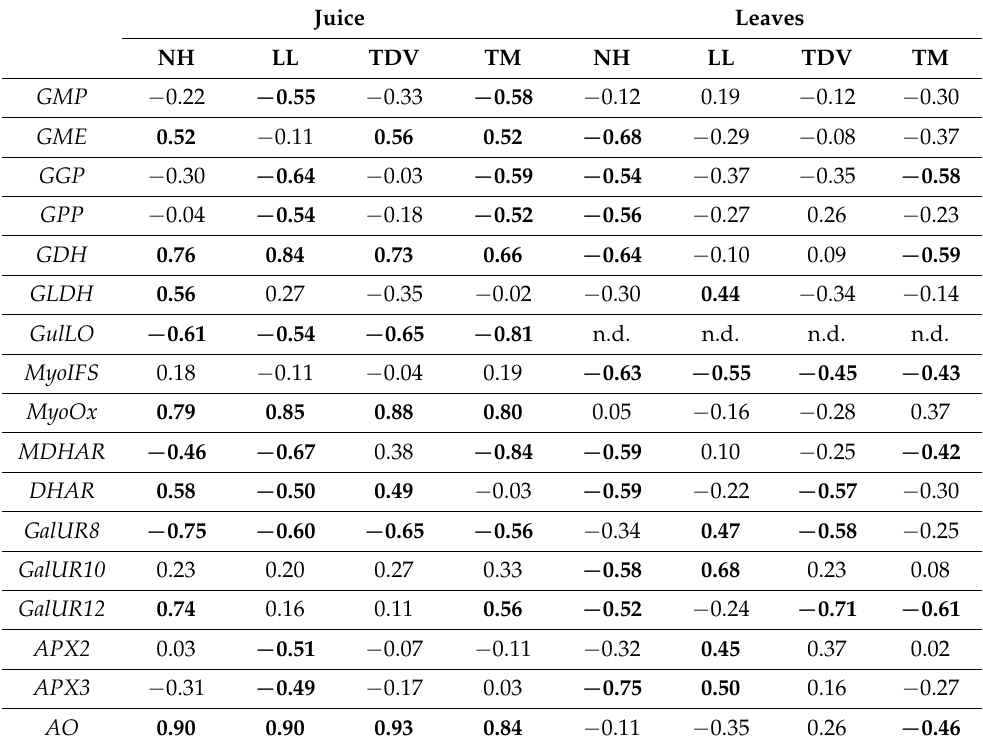
Table 1. Correlation between gene expression and AsA content in the juice and leaves of Lanelate (LL), Tarocco Meli (TM), Newhall (NH), and Tarocco TDV (TDV). Statistically significant correlations ( p ≤ 0.05) are highlighted in bold.